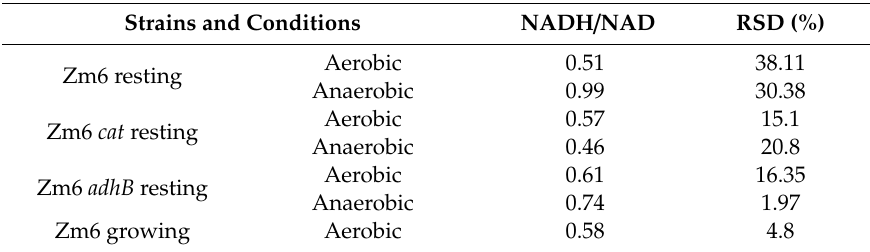
Table 2. NADH / NAD ratio in each Z. mobilis strain at steady state during resting cultivation. NADH / NAD ratio is an average of 4 technical replicates. RSD = relative standard